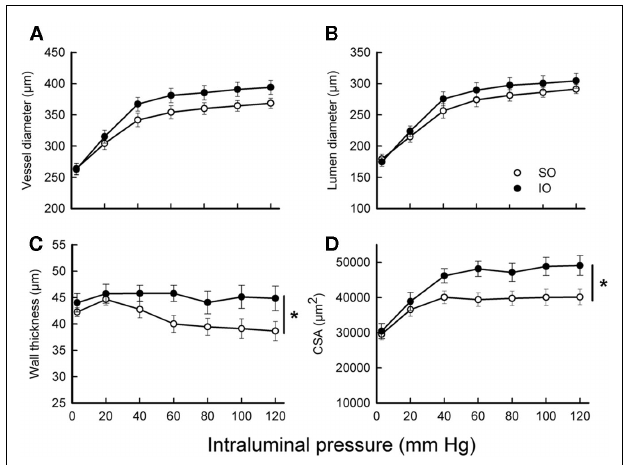
FIGURE 1 | Effect of mesenteric I/R on structural parameters from fully relaxed rat mesenteric resistance arteries. (A) Vessel diameter-intraluminal pressure. (B) Lumen diameter-intraluminal pressure. (C) Wall thickness-intraluminal pressure. (D) Cross-sectional area (CSA)-intraluminal pressure.Values are the mean ± SEM of n = 9–10. * P < 0.05 by two-way